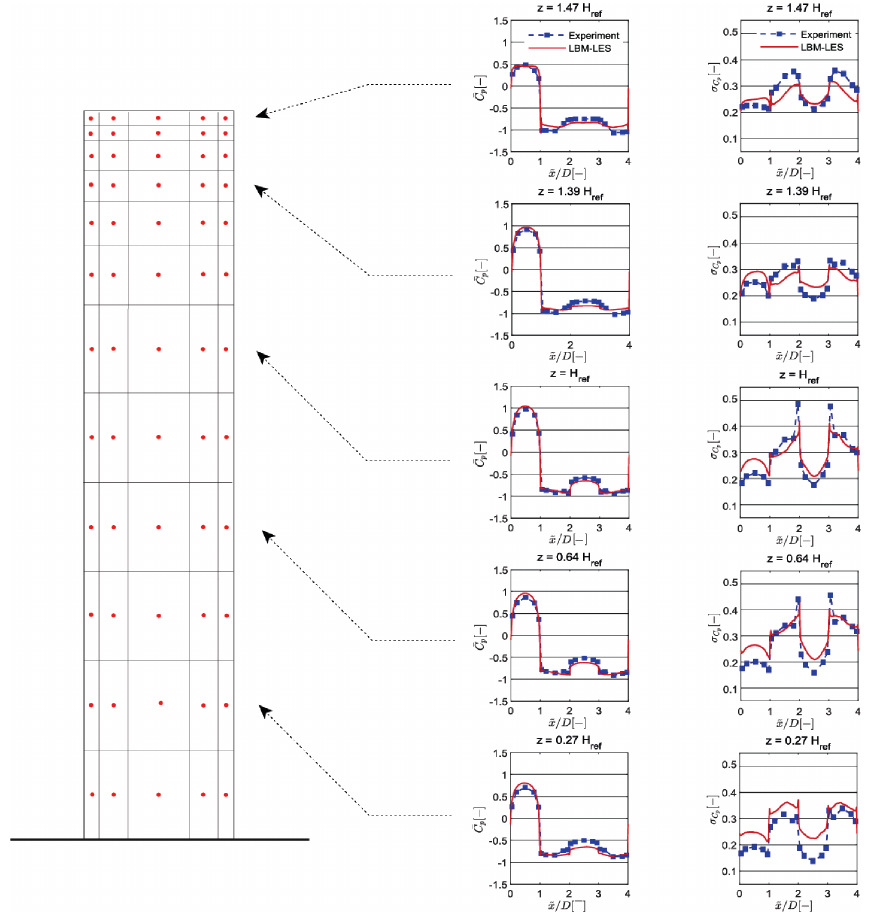
Figure 15. Reference and simulated pressure coefficients for the isolated high-rise building